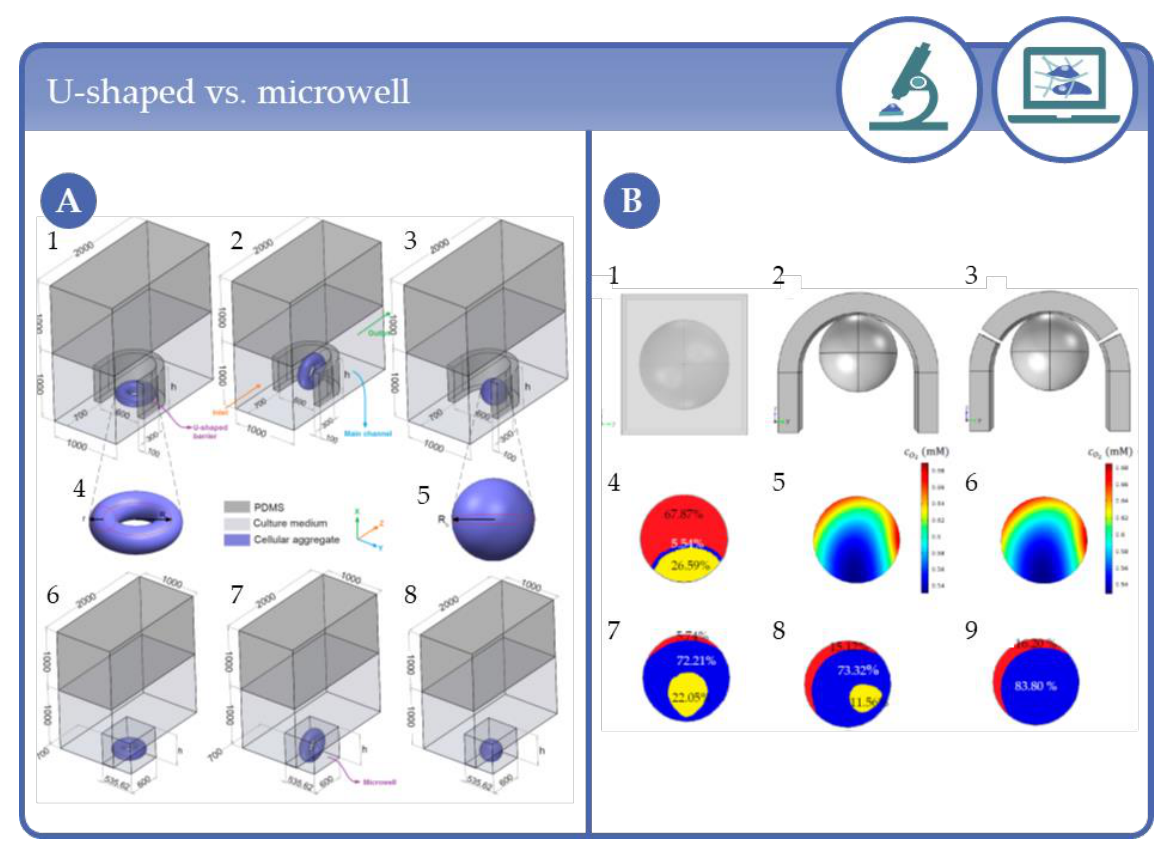
Figure 26. ( A ) Different experimental approaches (dimensions are in μm): (1) horizontal toroid in a U-shaped barrier; (2) vertical toroid in a U-shaped barrier; (3) spheroid in a U-shaped barrier; (4) toroid; (5) spheroid; (6) horizontal toroid in a microwell; (7) vertical toroid in a microwell and (8) spheroid in a microwell. Reprinted from [128] with permission from MDPI. ( B ) Simulation results of the different traps, i.e., (1) microwell structure; (2) integrated U-shaped barrier and (3) U-shaped barrier created with microposts, on the oxygen (4–6) and glucose (7–9) concentration distribution inside the spheroid and maximum shear stress on its surface (5) the proliferating, quiescent and necrotic zones due to oxygen deficiency in the middle x–z plane of the spheroid in the microwell, (6, 7) oxygen concentration distribution in the middle x–z plane of the spheroid in the integrated U-shaped barrier and U-shaped barrier created with microposts, respectively, (8, 9) the proliferating, quiescent and necrotic zones due to glucose deficiency in the middle x–z plane of the spheroid in the microwell, U-shaped barrier and U-shaped barrier created with microposts, respectively. Reprinted from [129] with permission from MDPI.